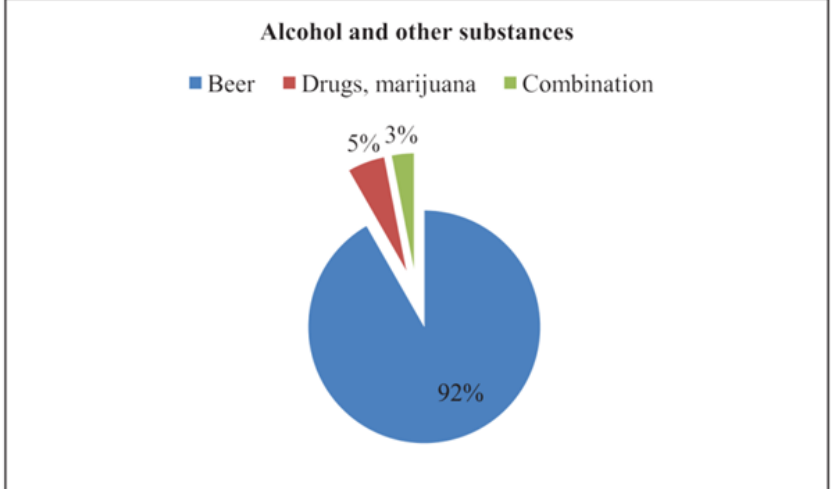
Figure 4. Alcohol and drug consumption: distribution of alcohol and drug use reported by ASG miners in Kadoma and Shurugwi in the 2020 rainy season, n = 97.